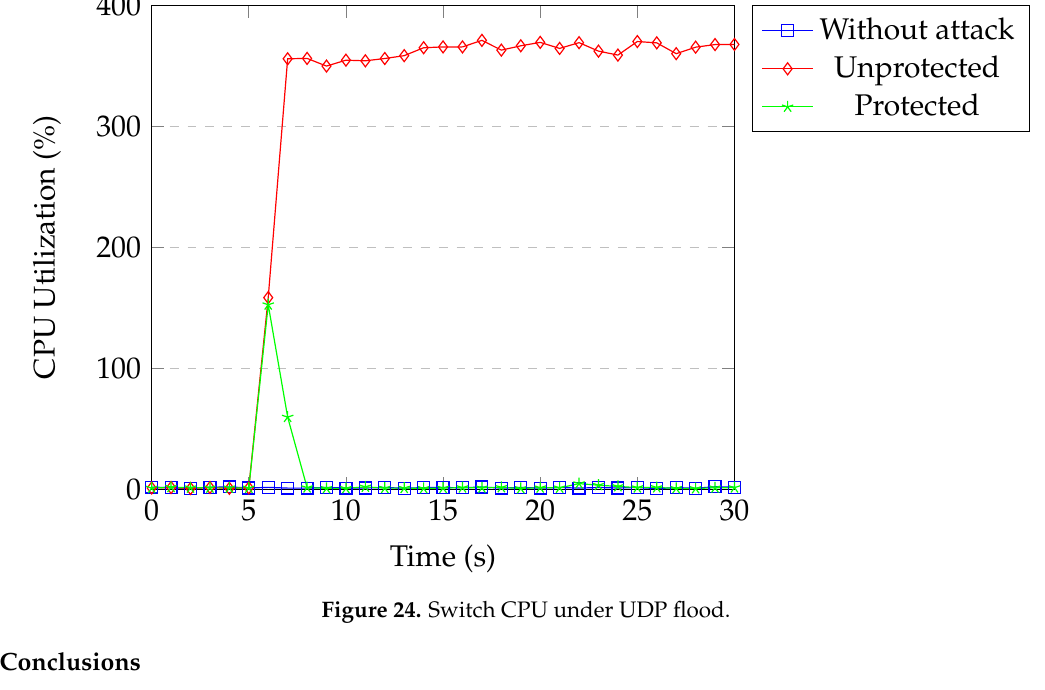
Figure 23. Controller CPU under UDP flood.